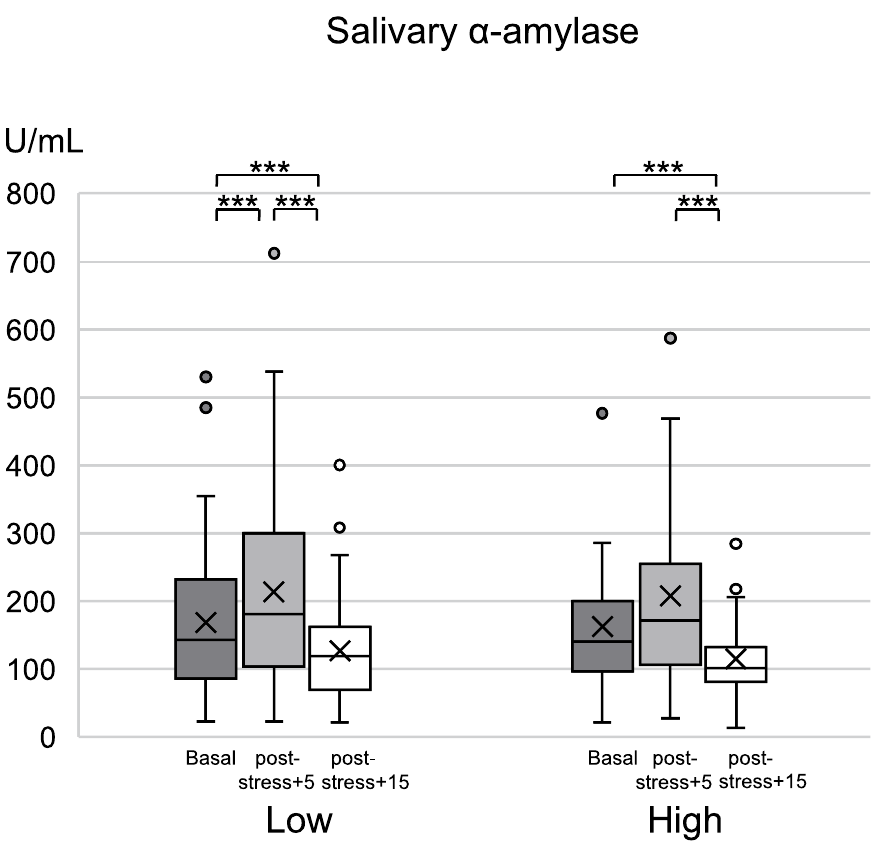
Fig 3. Salivary α -amylase activity in response to the TSST. Changes in salivary α -amylase activity in response to the TSST. � indicates significant differences. ��� p < 0.001.